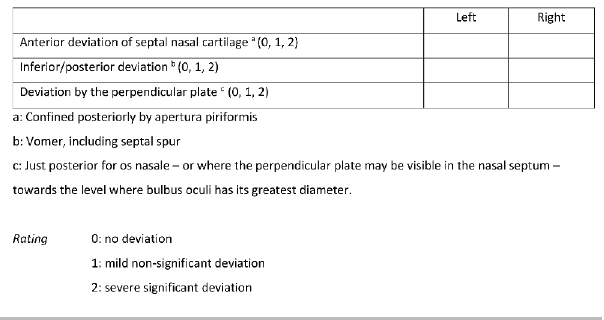
Figure 3. Nasal septal deviation scoring system for sinus CT